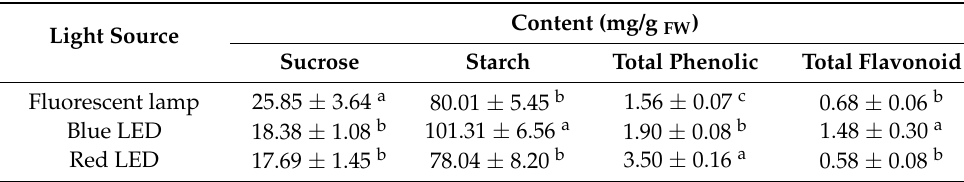
Table 5. Sucrose, starch, total phenolic content, and total flavonoid content of H. corymbosa (L.) Lam leaves after 4 weeks of being grown under different light sources at the same light intensity of 100 µ mol · m − 2 · s − 1 . Content (mg/g FW ) Light Source Sucrose Starch Total Phenolic Total Flavonoid Fluorescent lamp 25.85 ± 3.64 a 80.01 ± 5.45 b 1.56 ± 0.07 c 0.68 ± 0.06 b Blue LED 18.38 ± 1.08 b 101.31 ± 6.56 a 1.90 ± 0.08 b 1.48 ± 0.30 a Red LED 17.69 ± 1.45 b 78.04 ± 8.20 b 3.50 ± 0.16 a 0.58 ± 0.08